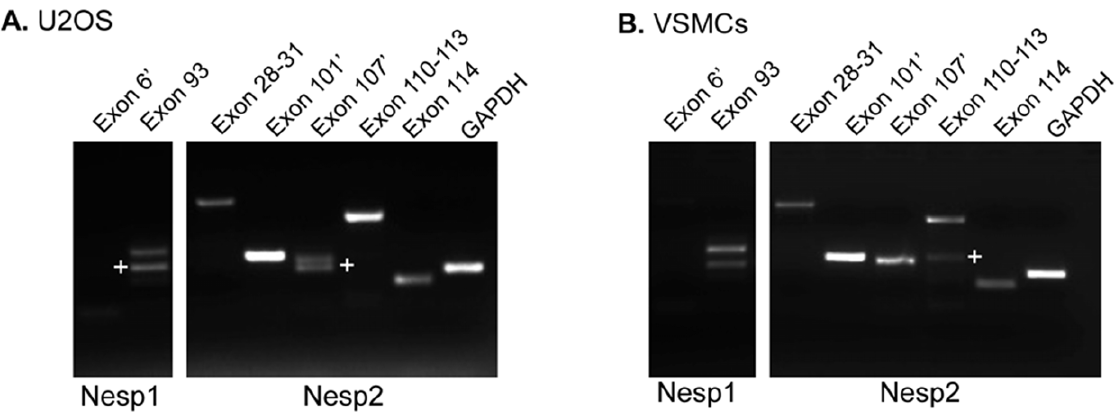
Figure 7. Identification of nesprin-1 and nesprin-2 splicing events. A) PCR amplification across splice sites was carried out from cDNA isolated from U2OS cells. Splicing of exon 93 for nesprin-1 was observed as was the splicing for nesprin-2 exon 107’. B) PCR amplification across splice sites was carried out from cDNA isolated from VSMCs. Splicing of exon 93 for nesprin-1 was observed. Exon 107’ was retained in all nesprin-2 transcripts while splicing of exons 110–113 was also observed in these cells. + Represents bands with exon(s)